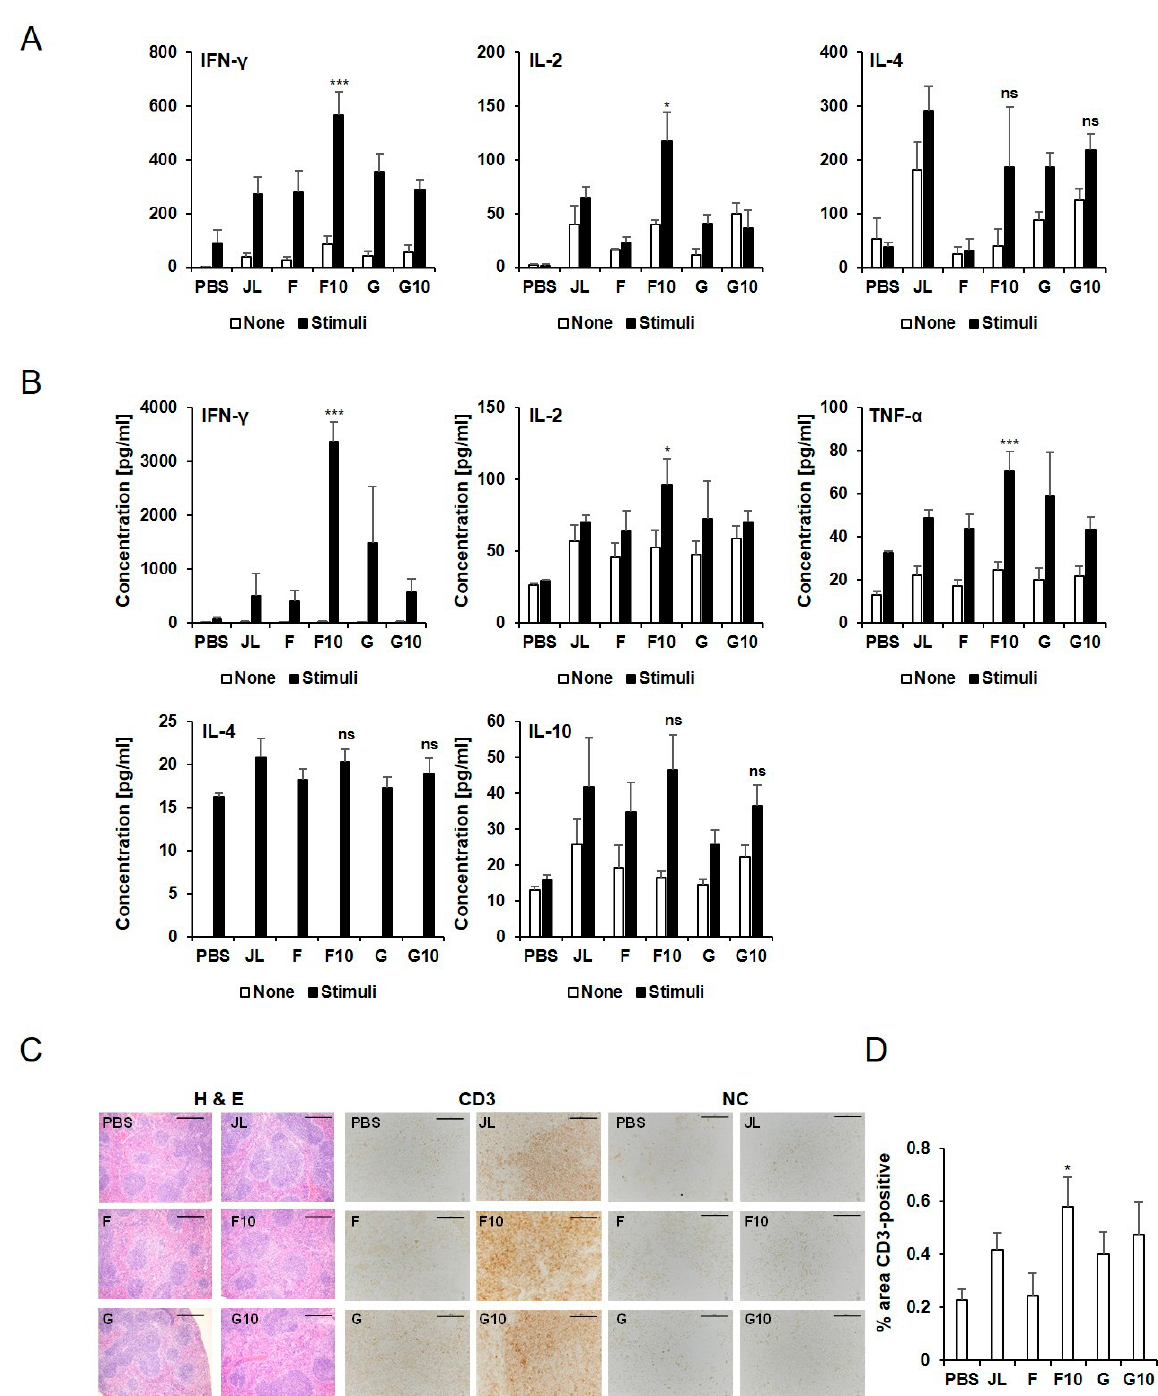
Figure 2. Cellular responses of inactivated mumps vaccine candidates. ( A ) IFN- γ , IL-2, and IL-4 ELISPOT analysis was performed, and the spots were counted. ( B ) Secreted IFN- γ , IL-2 TNF- α , IL-4, and IL-10 levels were detected by multiplex. Data are presented as the mean ± SD pooled from individual mice (N = 5). Th1 cytokine responses were significantly increased in the F10 immunized group (n = 5) compared to the JL immunized group. * p < 0.05, *** p < 0.005 analyzed by unpaired t -test. ( C ) CD3 levels were examined by IHC in spleen (N = 3). Representative staining images of the splenic history of immunized mice. ( D ) Percentage of immunostained area for CD3. Scale bar: 100 µ